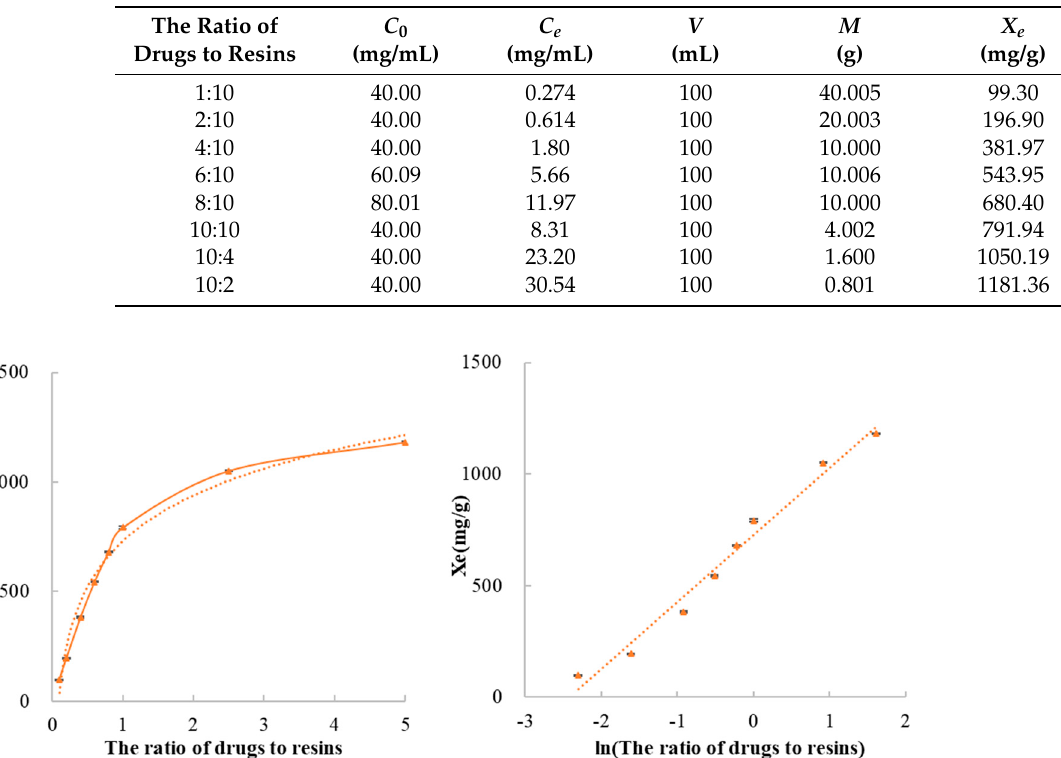
Table 2. Methylphenidate hydrochloride concentration in the drug–resin complex systems.